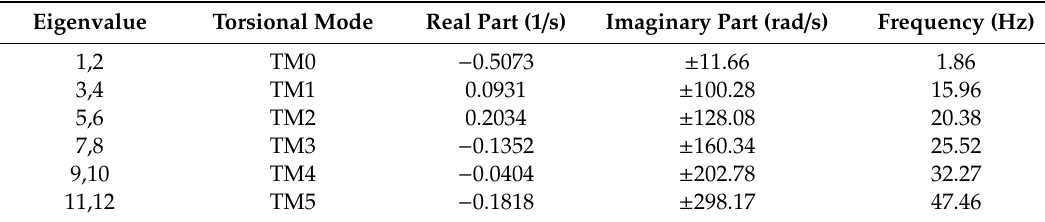
Table 3. Eigenvalues calculation result ( k C is